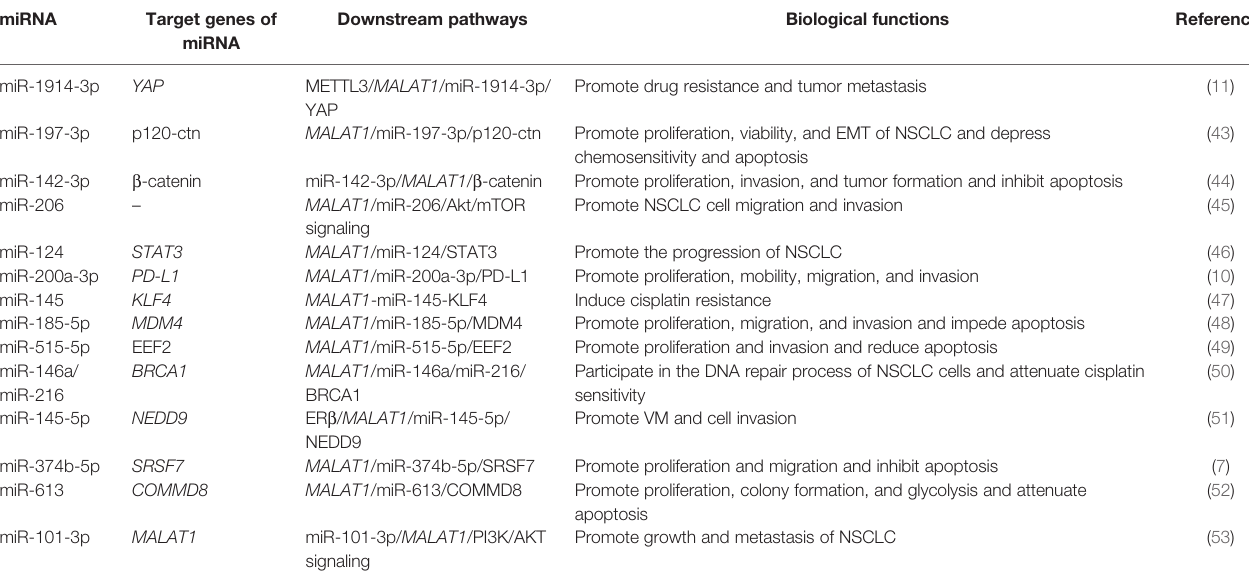
TABLE 1 | Mechanism and roles of the metastasis-associated lung adenocarcinoma transcript-1 ( MALAT1 ) in non-small cell lung cancer (NSCLC) progression. miRNA Target genes of